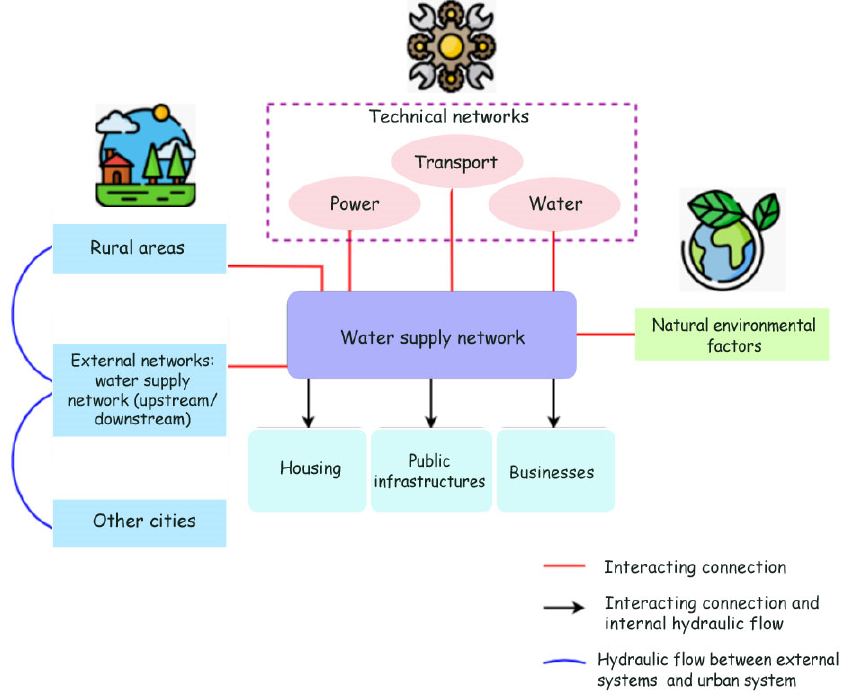
Figure 3. The strategy of a water supply network.